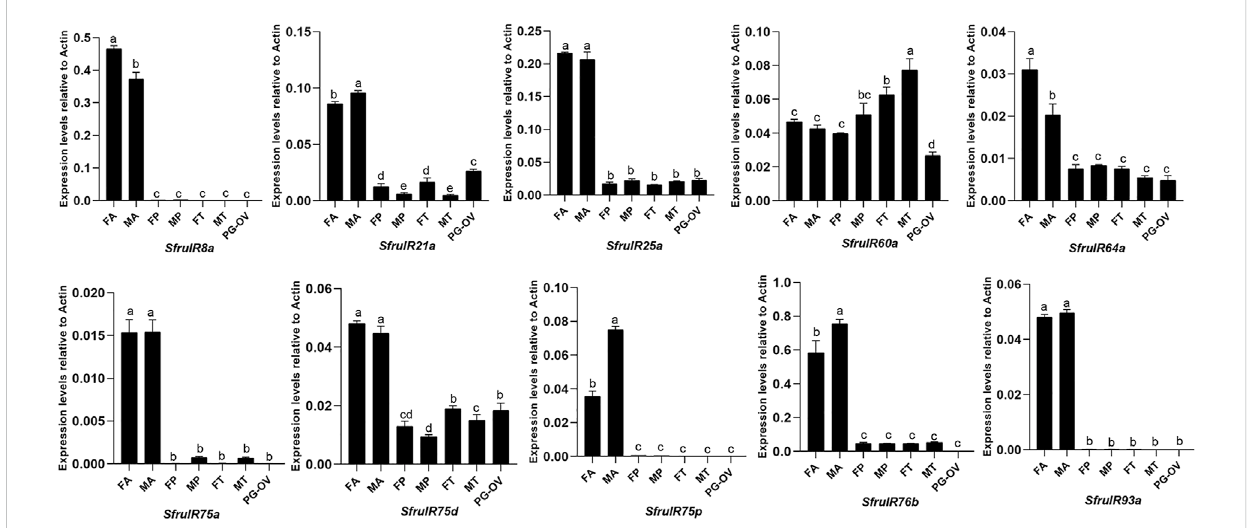
FIGURE 9 Expression patterns of candidate SfruIRs in different chemosensory tissues of adult S . frugiperda . FA: female antennae, MA: male antennae, FP: female proboscises, MP: male proboscises, FT: female tarsi, MT: male tarsi, PG-OV: female pheromone gland-ovipositor. Different letters indicate signi fi cant difference based on a one-way ANOVA followedby Tukey ’ smultiple comparison test. Error bars show the standard errors of the means (+SE), p < 0.05, n =